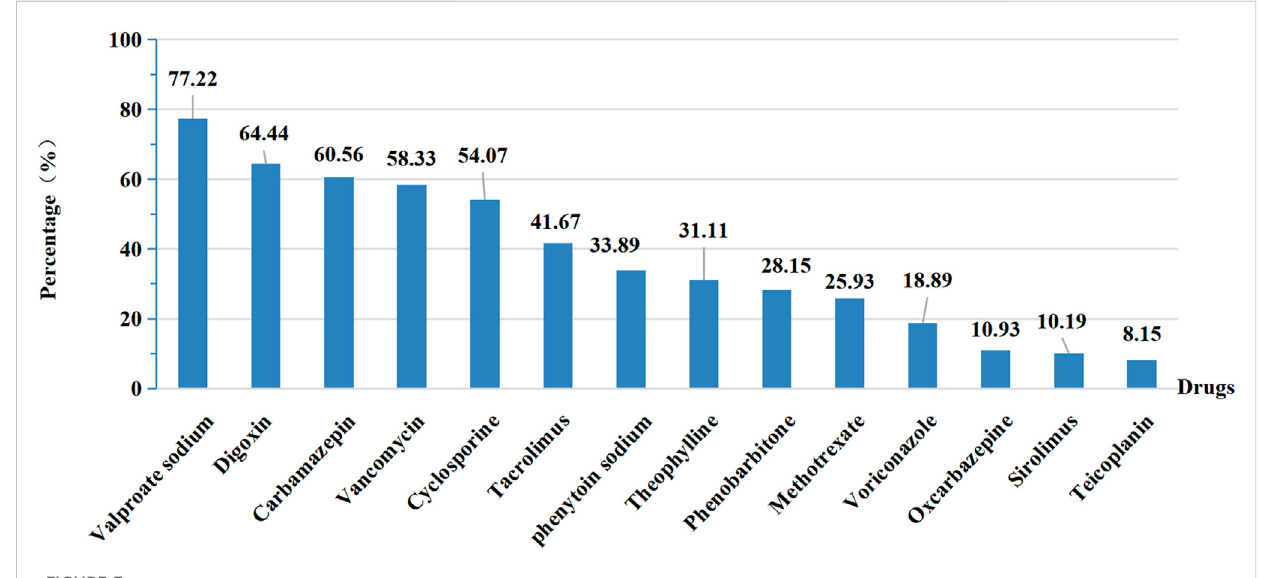
FIGURE 3 The percentage of drugs performed TDM in 540 hospitals.